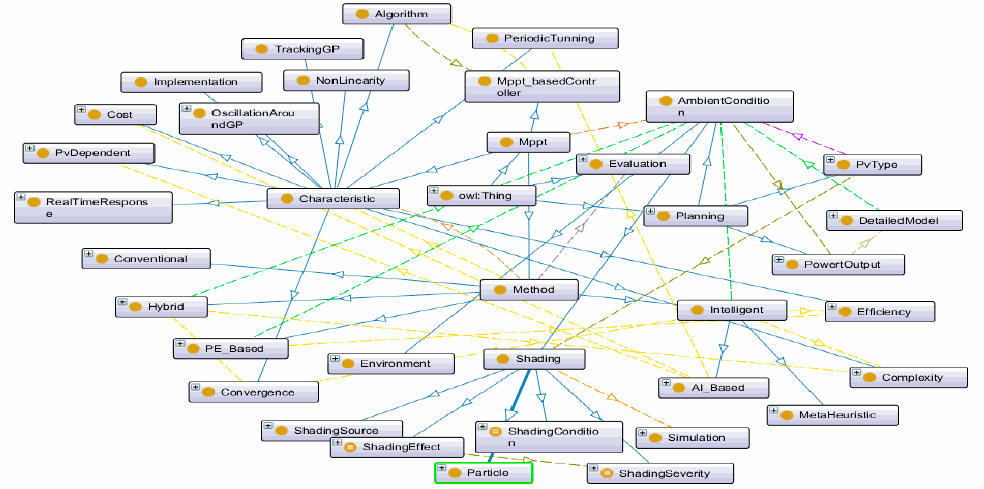
Figure 5. A graphical representation for MPPT characteristics and its